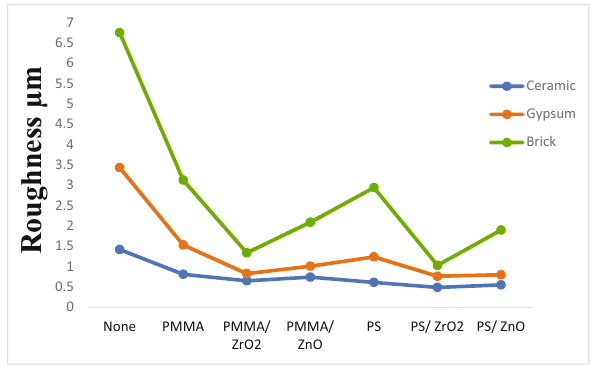
Figure 3: Roughness surface results for di ff erent